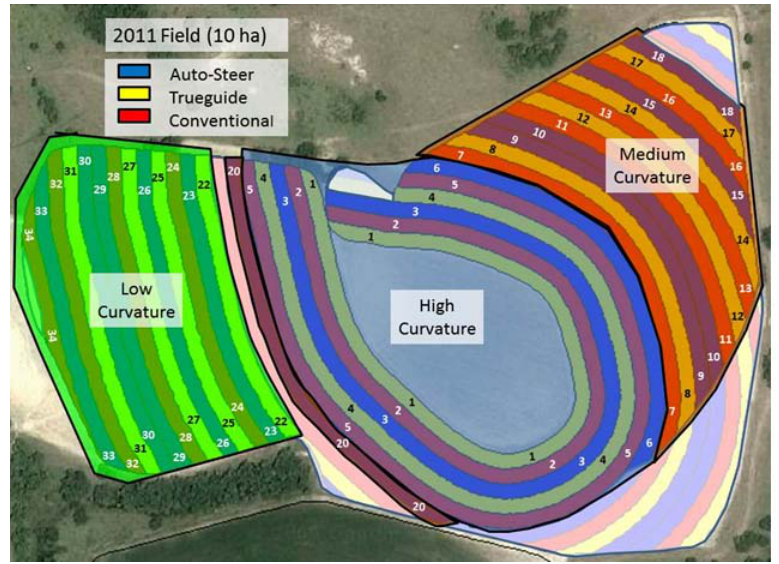
Figure 8. The 2011 field was divided into high, medium, and low curvature areas. Strip 20 is included in the medium curvature